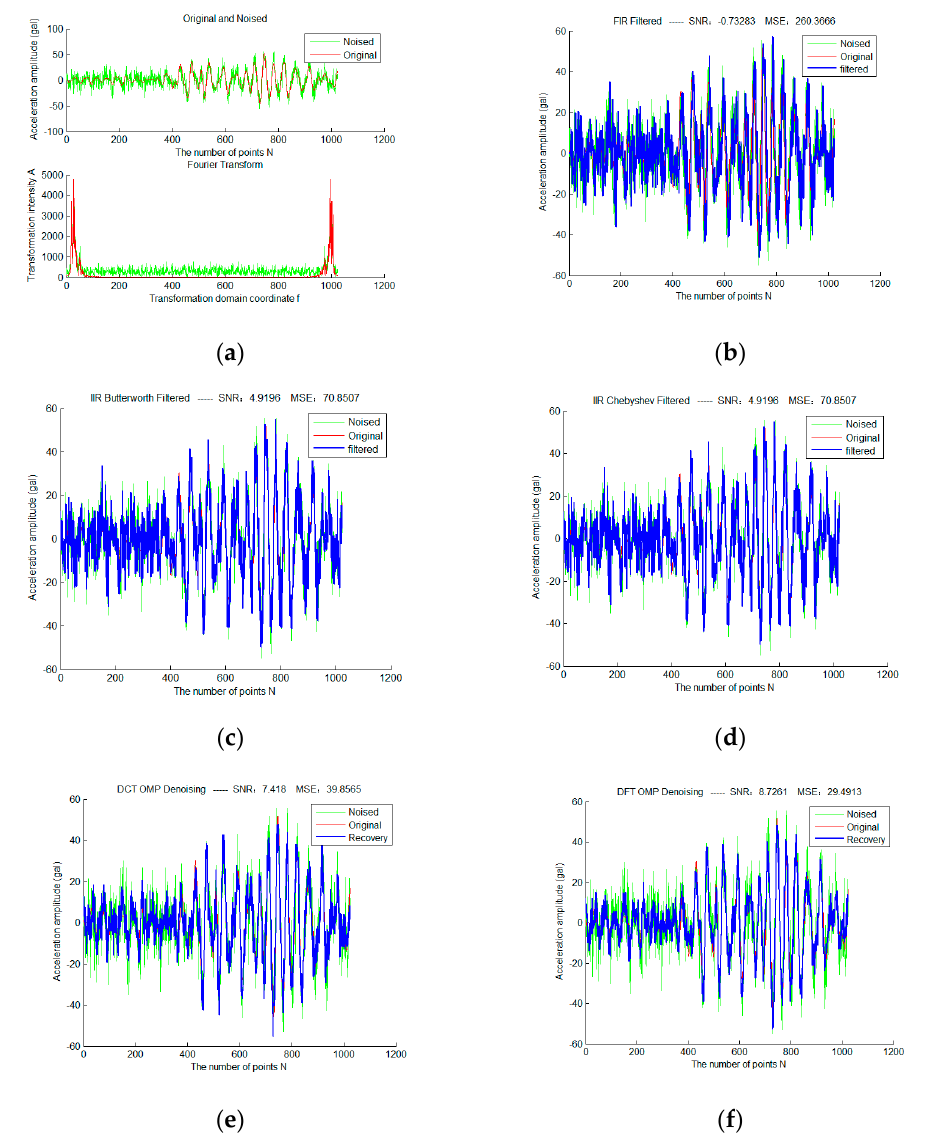
Figure 5. The Spare Denoising Experiment of a Frame of Strong Earthquake Signals Based on Different Fixed Dictionary ( a ) is the original and noise-adding waveforms of the frame signal in the time and frequency domain(sigma = 10); ( b ) is the result based on FIR filtering; ( c ) is the result based on Butterworth filtering; ( d ) is the result based on Chebyshev filtering; ( e ) is the OMP sparse representation denoising result based on the DCT dictionary; ( f ) is the OMP sparse representation denoising result based on the DFT dictionary.